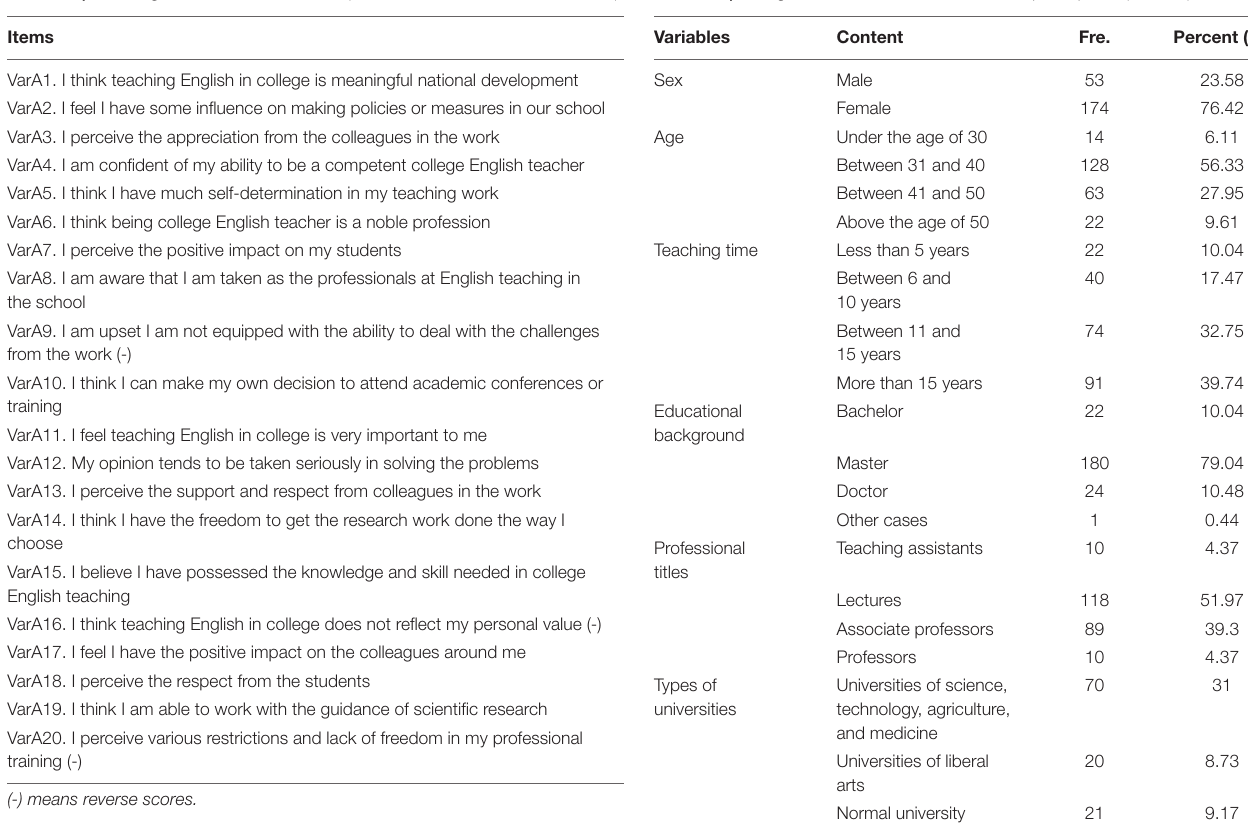
TABLE 4 | Background information of the teacher participants ( n =